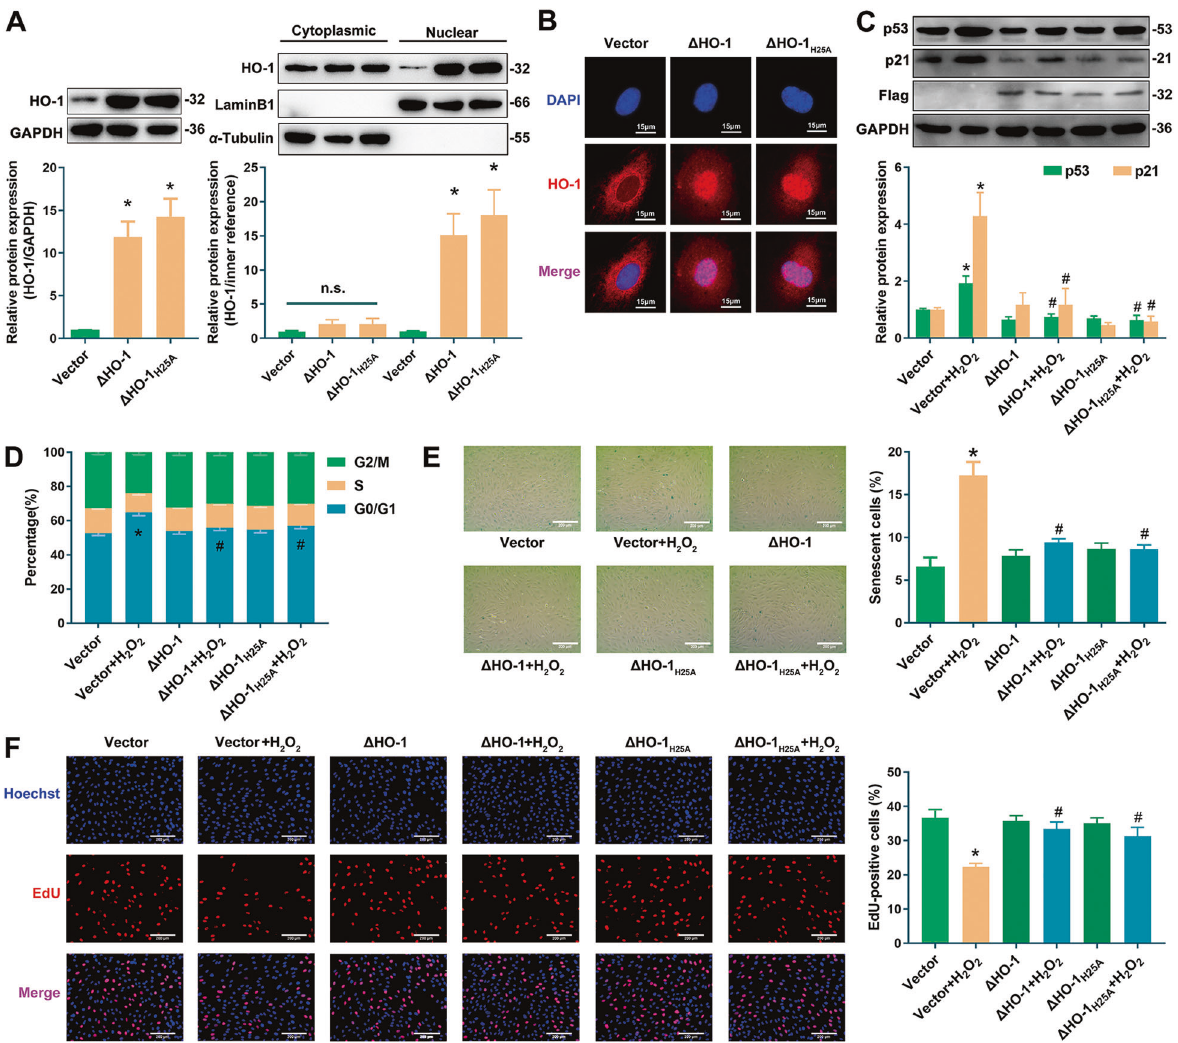
Fig. 2 Overexpressing nuclear HO-1 by transfecting with Δ HO-1 or Δ HO-1 H25A resisted endothelial senescence. A Overexpression of HO-1 was detected in HUVECs transfected with Δ HO-1 or Δ HO-1 H25A . * P < 0.05 vs. Vector. n = 5. B Fluorescence signal of HO-1 was enriched in the nucleus. n = 3. C Nuclear accumulation of HO-1 in HUVECs transfected with Δ HO-1/ Δ HO-1 H25A reversed the increasing expression of p53/p21 in senescent cells induced by H 2 O 2 . * P < 0.05 vs. Vector; and # P < 0.05 vs. Vector + H 2 O 2 . n = 4. D Nuclear accumulation of HO-1 ameliorated G0/ G1 cell cycle arrest induced by H 2 O 2 . * P < 0.05 vs. Vector; and # P < 0.05 vs. Vector + H 2 O 2 . n = 5. E Nuclear accumulation of HO-1 reversed the increasing proportion of SA- β -gal-positive cells induced by H 2 O 2 . * P < 0.05 vs. Vector; and # P < 0.05 vs. Vector + H 2 O 2 . n = 5. F Nuclear accumulation of HO-1 reversed the decreasing ratio of EdU-positive cells. * P < 0.05 vs. Vector; and # P < 0.05 vs. Vector + H 2 O 2 . n =